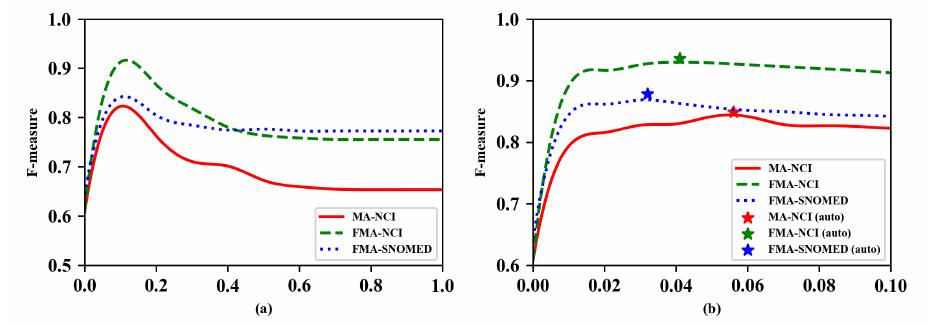
Figure 6. ( a ) Sensitivity analysis of the performance (F-measure) with different threshold values. ( b ) Comparative analysis of the automated threshold and manual threshold about performance